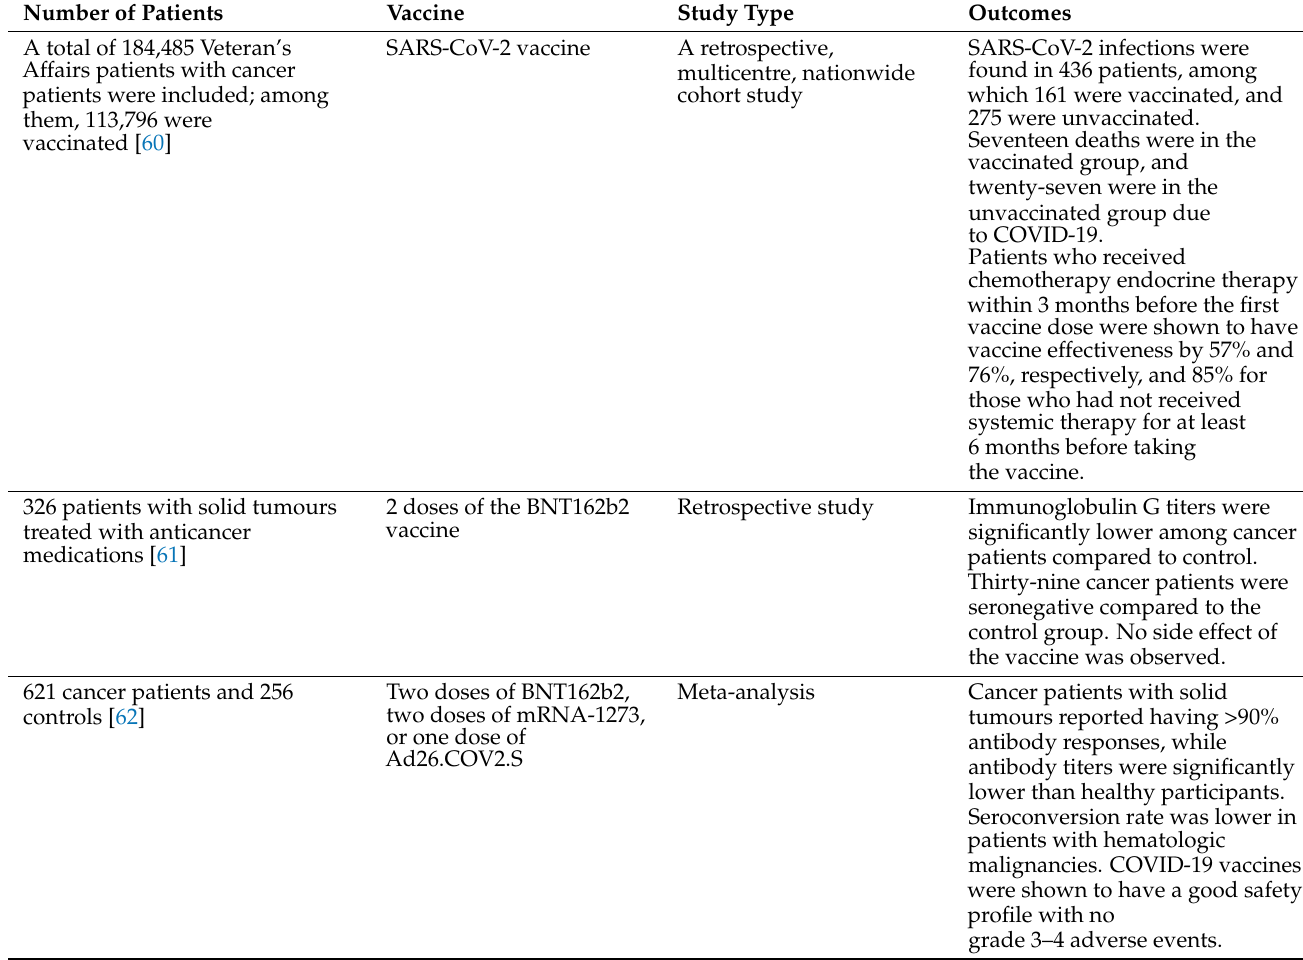
Table 2. Impact of COVID-19 vaccine on cancer